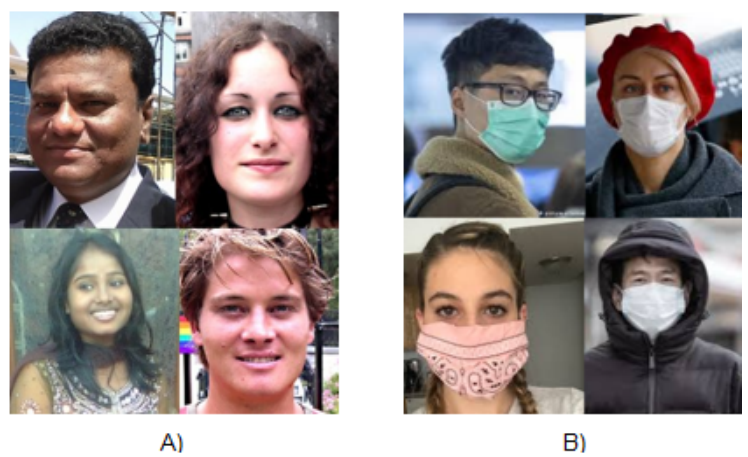
Figure 4. Sample images from dataset used in this study to train and validate the proposed model ( A ) without and ( B ) with